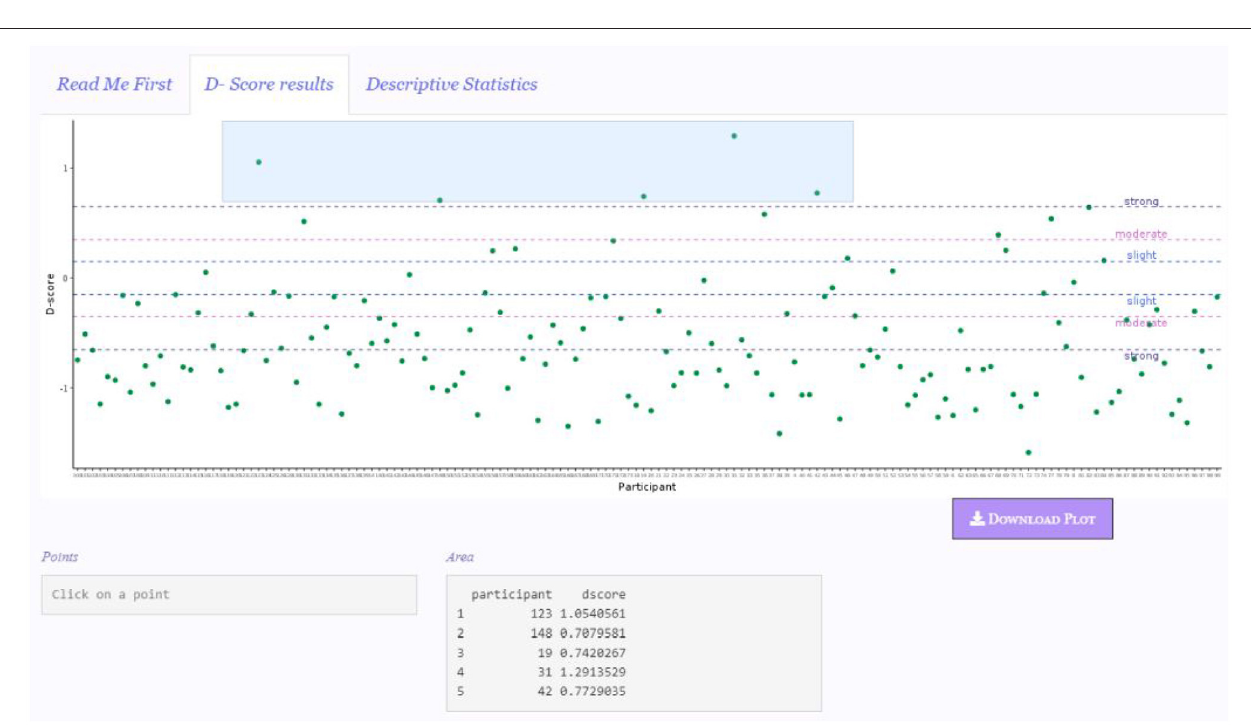
FIGURE 4 | Area highlighter for detecting participants’ D-score